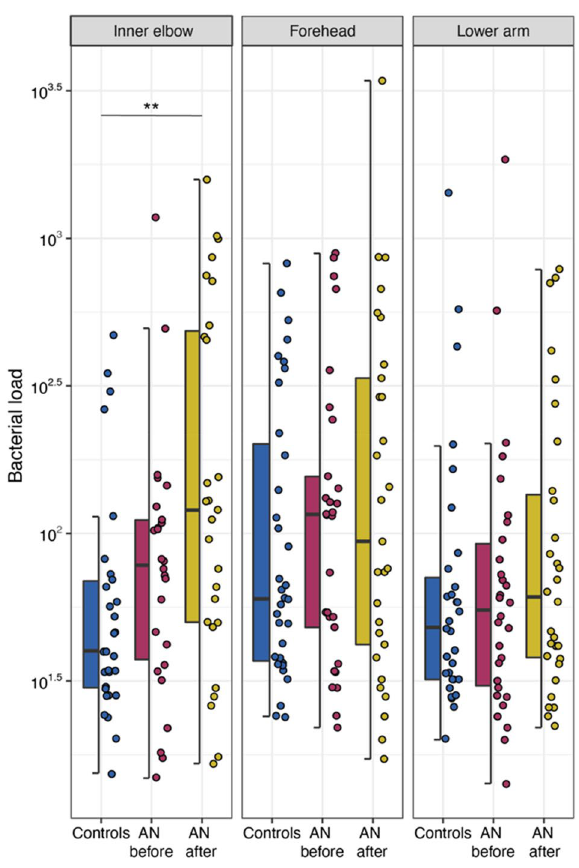
Figure 2. Box plots of total bacterial load, as measured by ddPCR, for study groups at individual sampling locations. AN = anorexia nervosa. Wilcoxon test (see “Methods” section); p -values: *< 0.05; **< 0.01; ***< 0.001. p -values were adjusted for multiple testing according to Benjamini and Hochberg 94 . Line indicates the median concentration; box shows the interquartile range (IQR), and the whiskers are 1.5 × IQR. Blue represents healthy- weight controls, red represents patients with AN before weight gain, and gold represents patients with AN after weight